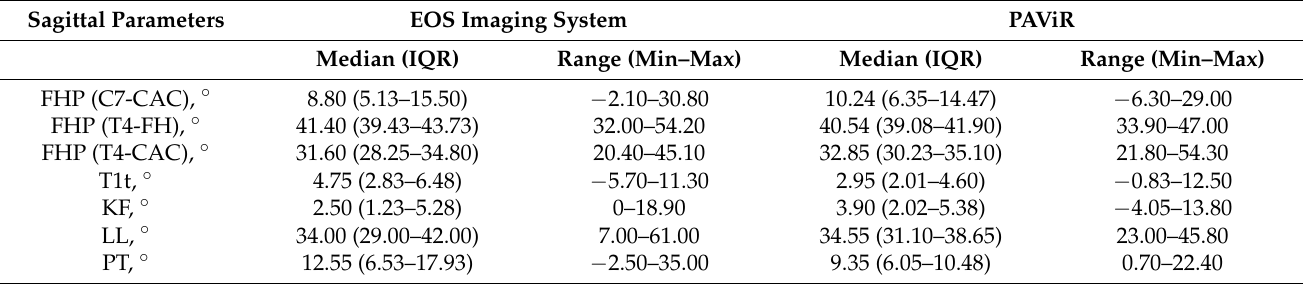
Table 3. Descriptive values of the sagittal parameters measured with EOS imaging system and PAViR.